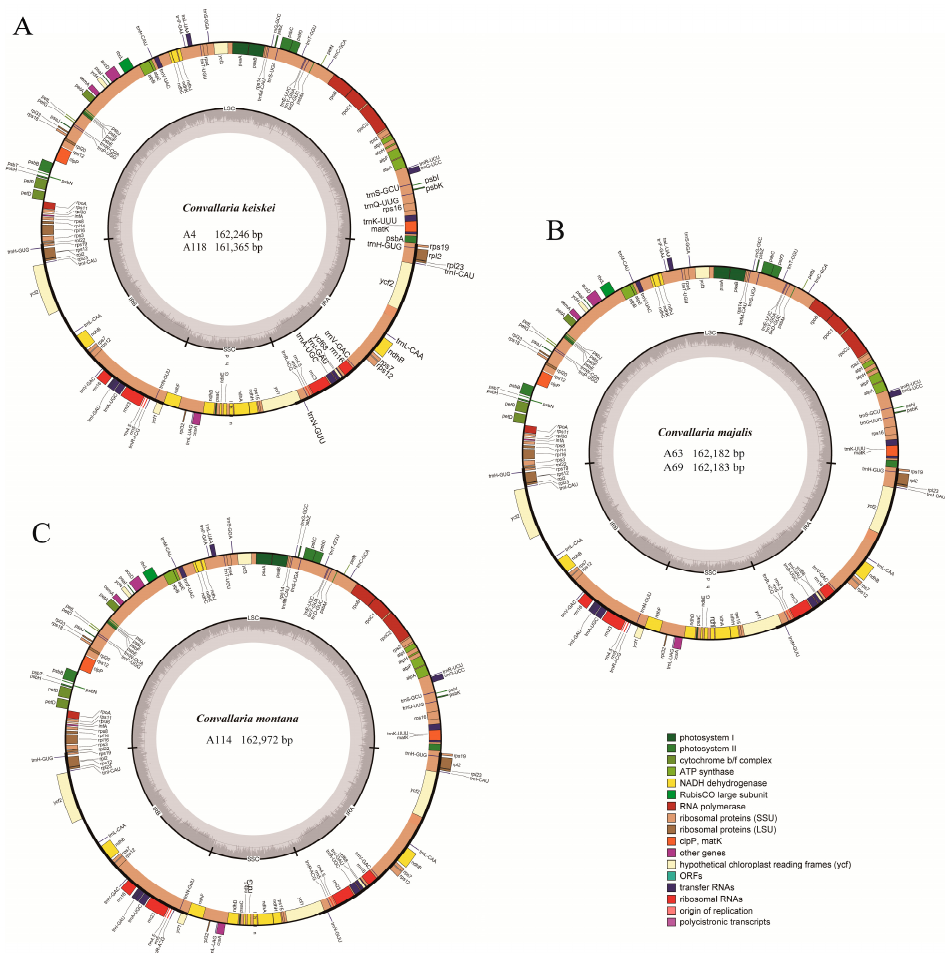
Figure 1. Gene maps of the five Convallaria chloroplast genomes. ( A ) Two C. keiskei individuals; ( B ) two C. majalis individuals; ( C ) one C. montana individual. Different color indicates different functional gene groups. The dark gray in the inner represents GC content, and the light gray represents AT